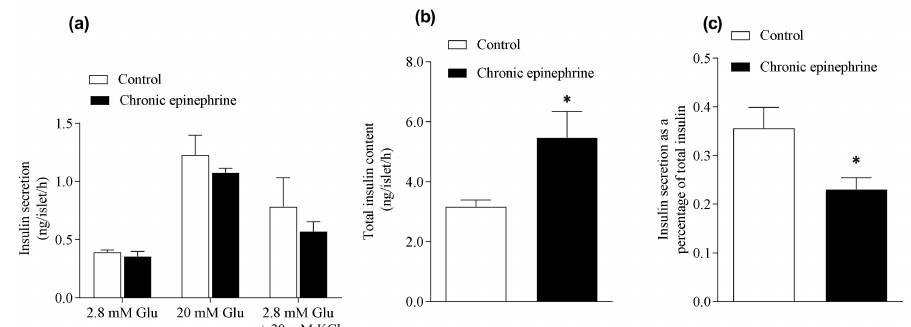
Figure 3. Glucose stimulated insulin secretion in islets after chronic Epi exposure. ( a ) Insulin secretion responsiveness was not different between chronic Epi exposure group ( n = 4) and control ( n = 5) with 2.8 mM glucose, 20 mM glucose and 2.8 mM glucose plus 30 mM KCl; ( b ) total insulin contents in islets; ( c ) insulin release as a fraction of islet insulin content. *, p < 0.05. Glu, glucose.